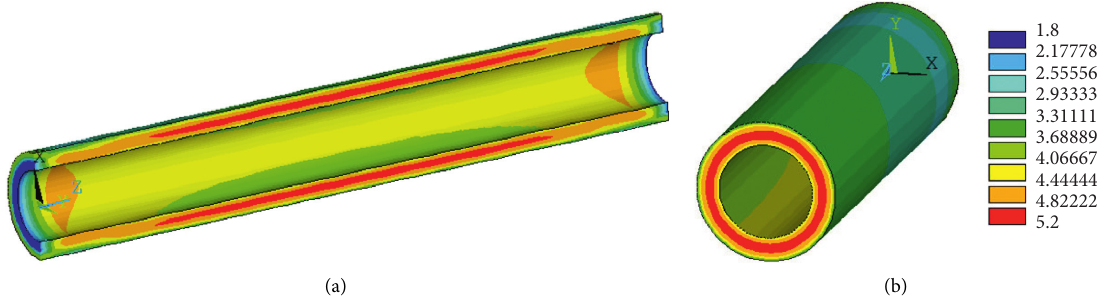
Figure 10: Stress envelope diagram of tunnel model for BC along and vertical to flow direction (MPa).